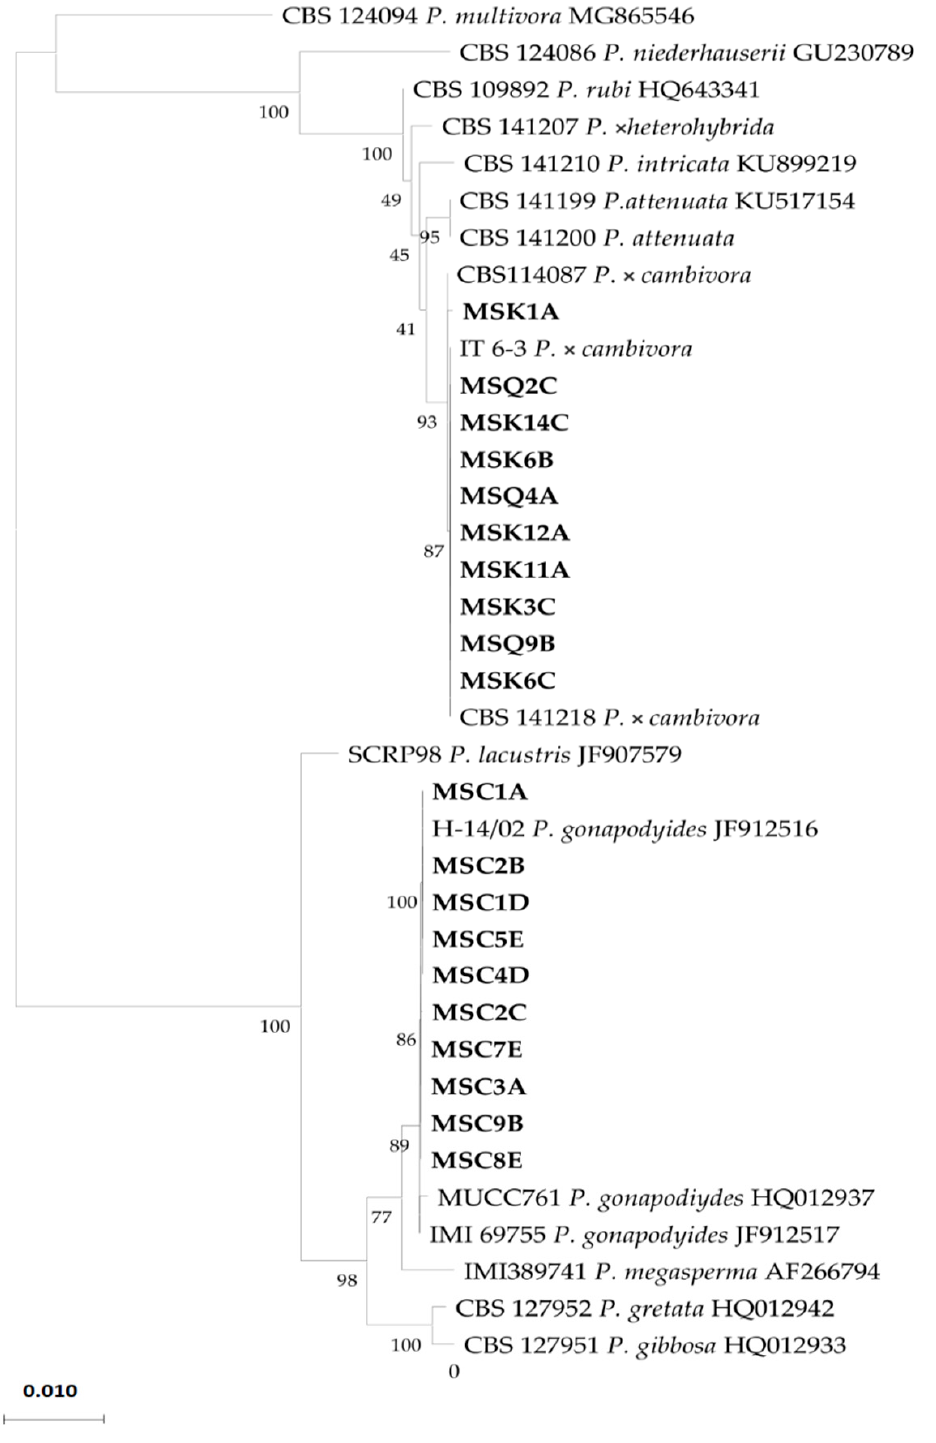
Figure 6. Internal transcribed spacer (ITS) and Cox I multilocus phylogenetic tree developed using the maximum likelihood method, based on the Tamura–Nei model. The tree with the greatest log likelihood (-5740.14) is shown. Relationships between the isolates from Fagus sylvatica sourced in southern Italy (in bold) and the CBS/IMI reference isolates of Phytophthora gonapodyides , P. × cambivora , and other Phytophthora spp. are shown. Table 1. Isolates of Phytophthora sourced from rhizosphere soil and different tissues (fine roots and stem bark) of European beech (Fagus sylvatica) trees in the Nebrodi Regional Park of Sicily, Italy, as characterized in this study.